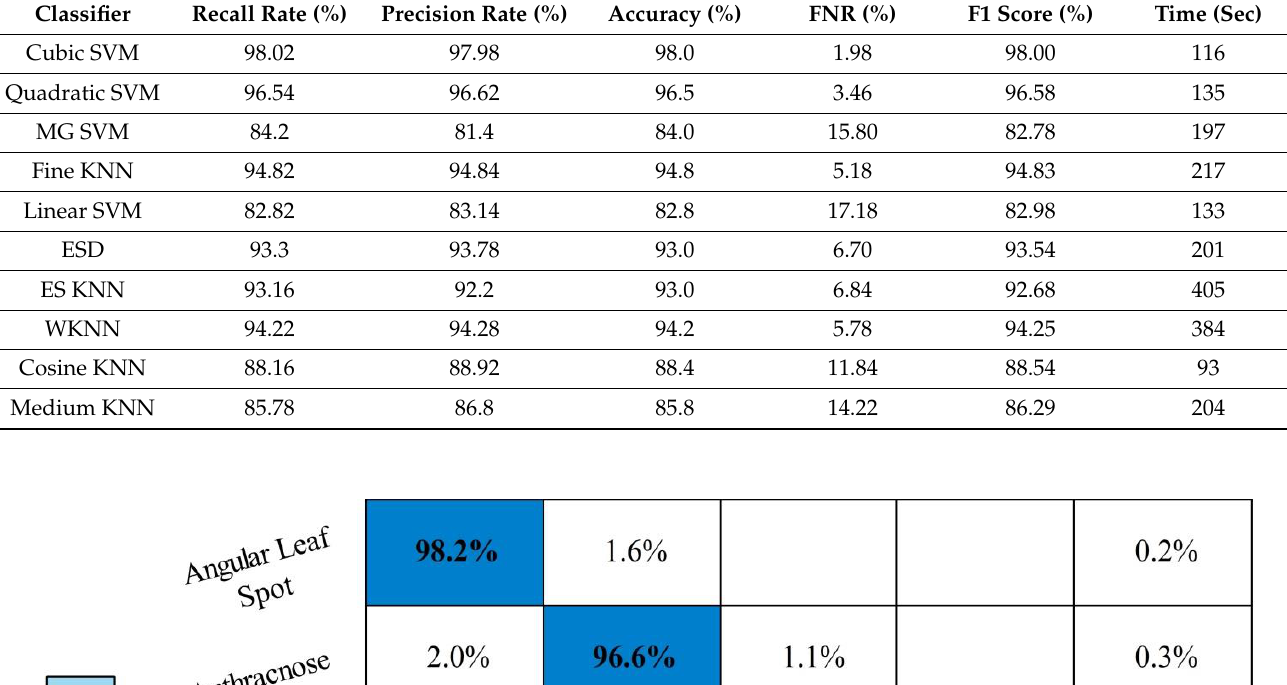
Table 7. Classification results using proposed Entropy-ELM selection approach.